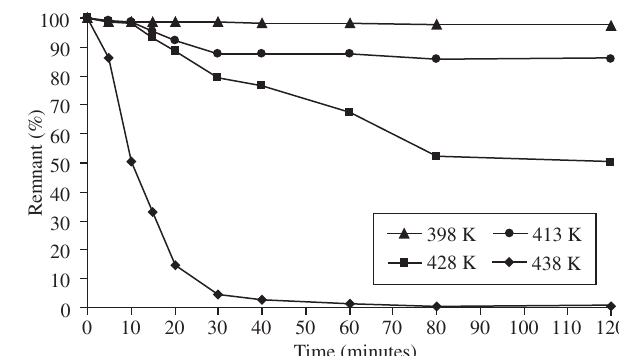
Figure 10. MB reaction test response with grape stalk activated carbon.